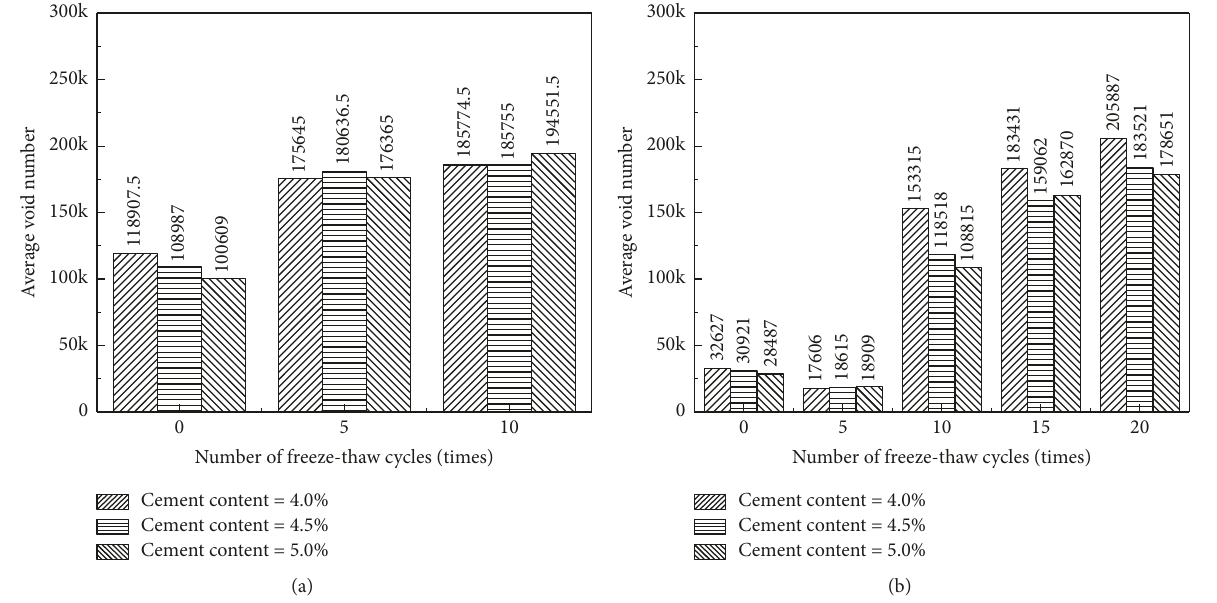
Figure 11: Effect of the number of freeze-thaw cycles, cement content, and curing time on the number of voids: (a) curing time = 28 d; (b) curing time =